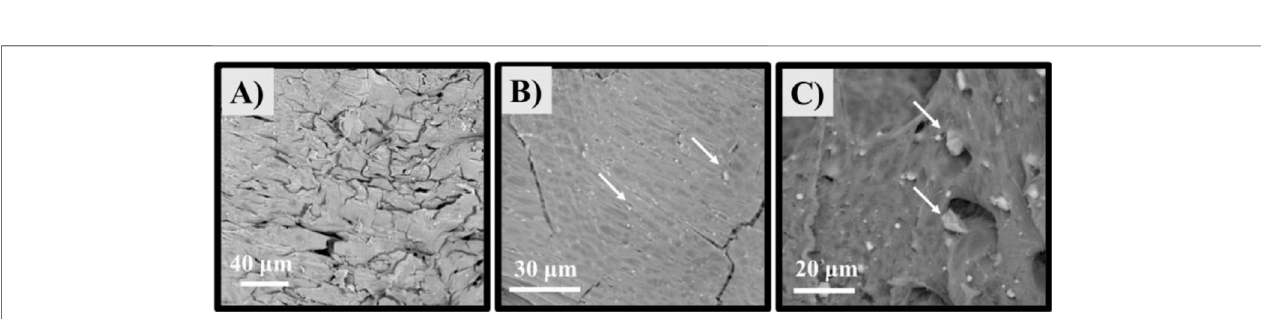
FIGURE 5 | SEM micrographs ofproduced fi laments cross-section. A) PLLA, B) PLLA_MBG_SG_10%Sr and C) PLLA_HA_50%Sr. The white arrows indicate the inorganic phases embedded into the PLLA matrix.